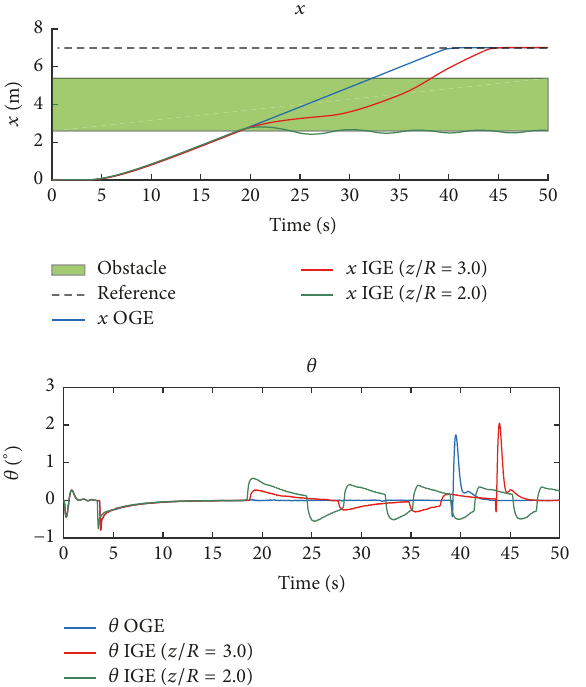
Figure 12: PID controller: flying over obstacle.